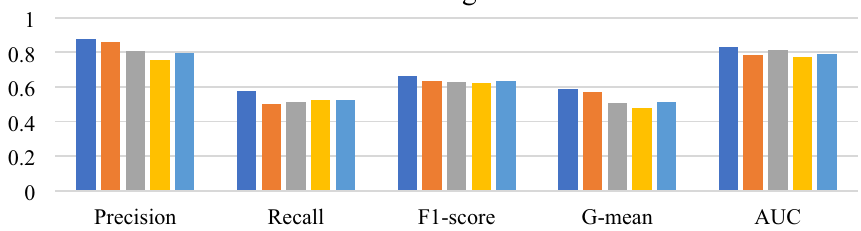
Evaluation index results using SPECTF heart